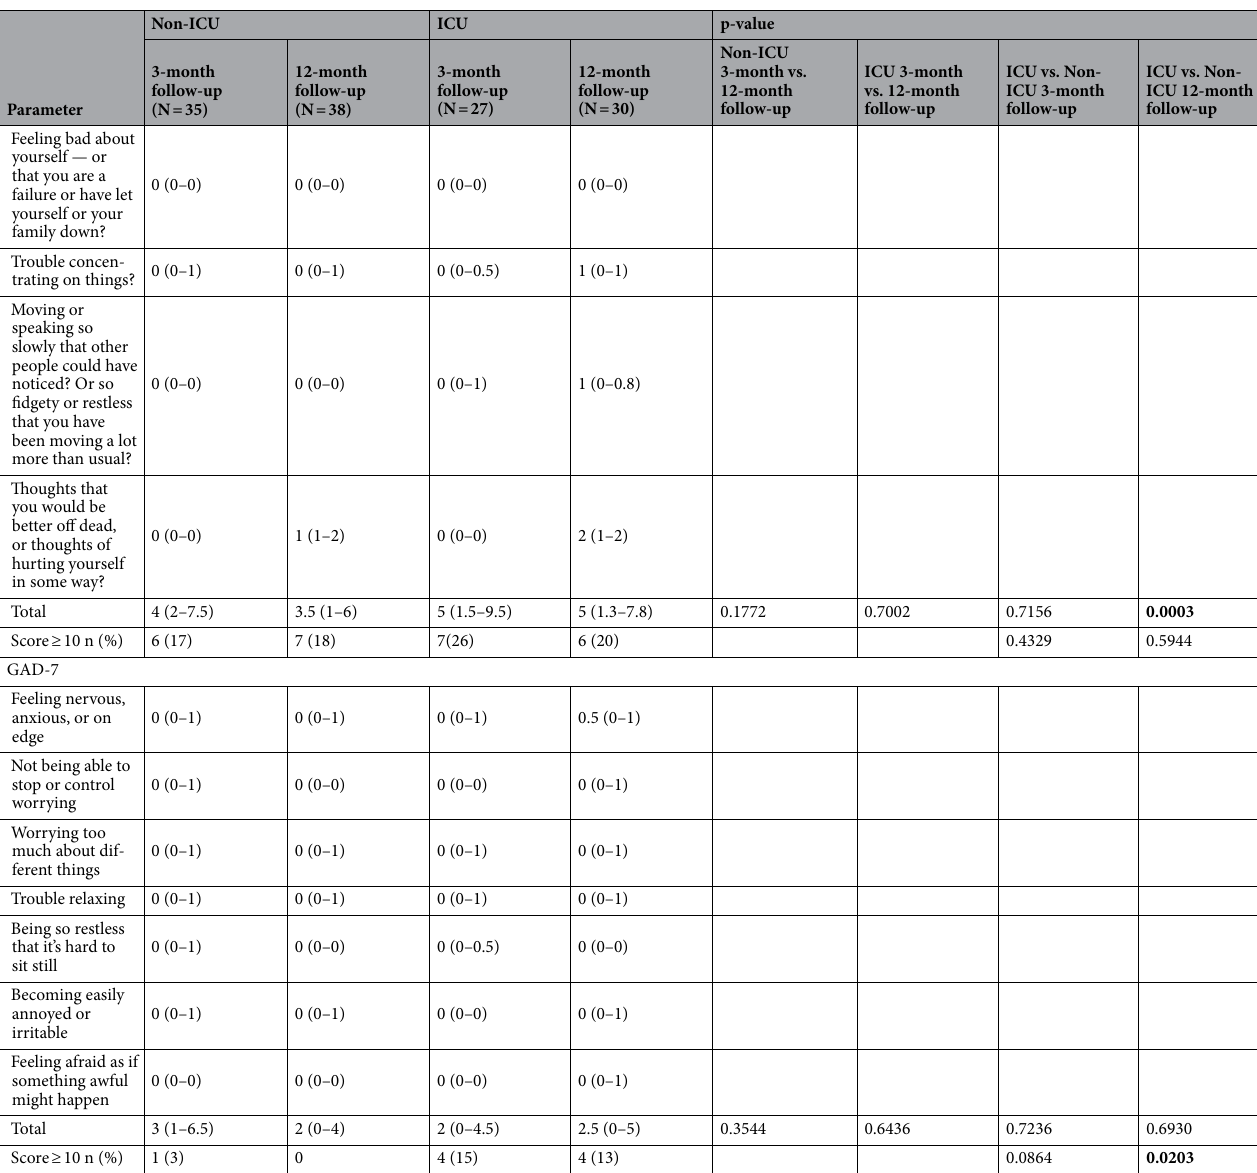
Table 2. Functional status as well as questionnaire results for general HRQoL. EQ-5D-5L (European Quality of Life 5 Dimensions 5 Level Version), PHQ-9 (Patient Health Questionnaire-9) and GAD-7 (Generalized Anxiety Disorder 7) Each of the five dimensions comprising the EQ-5D is divided into five levels of perceived problems (1: indicating no problem, 2: indicating slight problems, 3: indicating moderate problems, 4: indicating severe problems, 5: indicating unable to/extreme problems). EQ-5D-5L VAS is scaled from 0 (the worst health you can imagine) to 100 (the best health you can imagine). PHQ-9 and GAD-7 are a self-report measures, whereas respondents are asked to rate each of the items on a scale of 0 to 3 based on how much a symptom has bothered them over the last 2 weeks (0: not at all, 1: several days, 2: more than half the days, 3: nearly every day). Scores for each item are added up to get a total. A PHQ-9 score ≥ 10 was utilized for detecting major depressive disorder. A GAD-7 score ≥ 10 represents a reasonable cut point for identifying cases of GAD. Results are median plus interquartile range or percentage of patients as indicated. EQ-5D-5L-index values calculated using the German value set are mean ± SD. Significant values are in